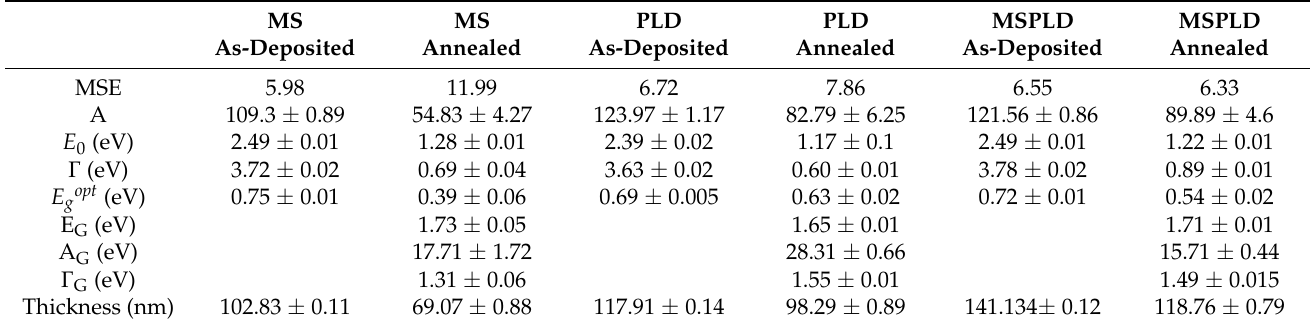
Table 5. Best fit model parameters with errors of the studied Ge 2 Sb 2 Te 5 thin